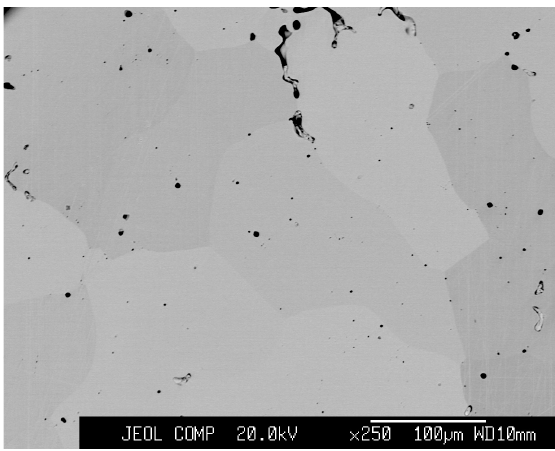
Figure 1. SEM micrograph taken using back-scattered electrons for Pd 2 Mn 1.4 Sn 0.6 at room temperature.